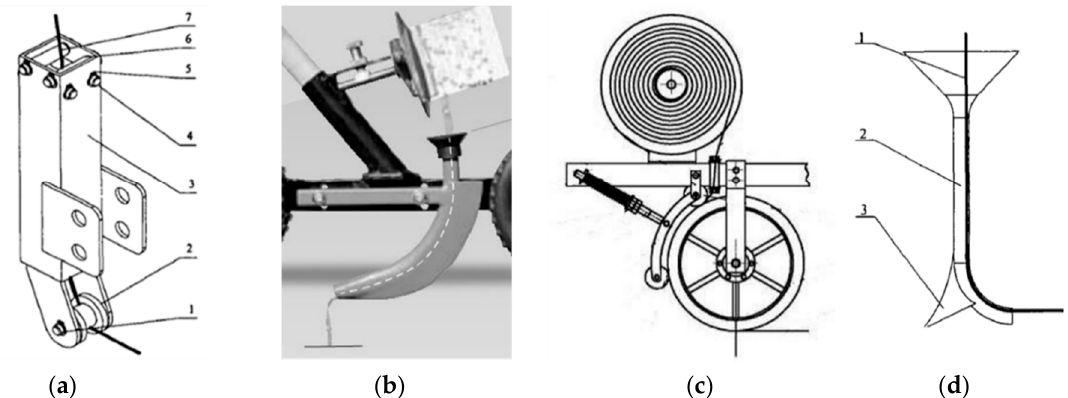
Figure 7. Kinds of tape guiding system. ( a ) Tape guiding system designed by Lv, 1. Axle of tape guiding wheel 2. tape guiding wheel 3. Shell 4. Axle of tape guiding pipe 5. Gasket 6. tape guiding pipe 7. Seed tape [84]; ( b ) Knife guide tape opener (https://www.sedos.sk/Data/1049/UserFiles/SEDOS%20Catalogue%202012%20ENG.pdf (accessed on 8 October 2021)); ( c ) Press-in tape guiding mechanism [88]; ( d ) Core-drawing tape guiding opener, 1. Seed tape 2. Tape guiding pipe 3. Furrower